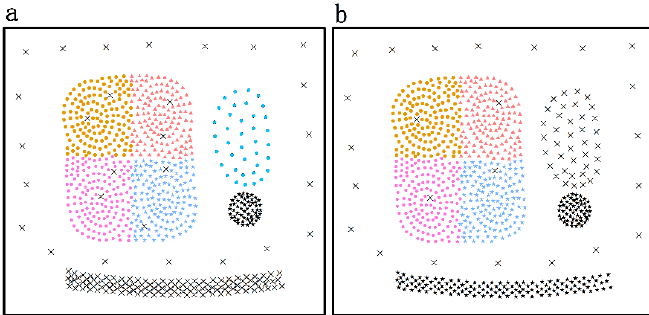
Figure 10. Clustering results of DTSC and typical algorithms on 𝑆1 : ( a ) result of DTSC algorithm; and ( b ) result of density-based time series clustering algorithm.